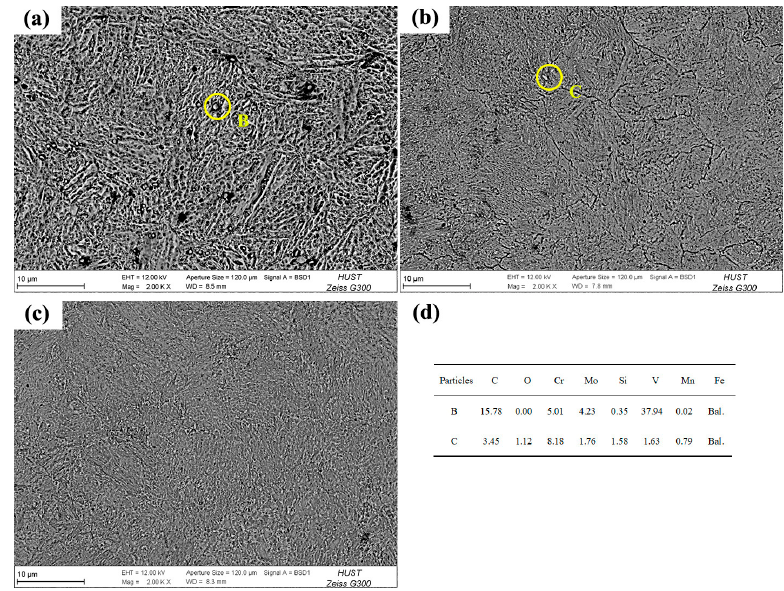
Figure 6. SEM images of the ( a ) Forged ( b ) As-SLMed, and ( c ) T-SLMed part after TF tests. ( d ) Chemical compositions of the indicated particles.